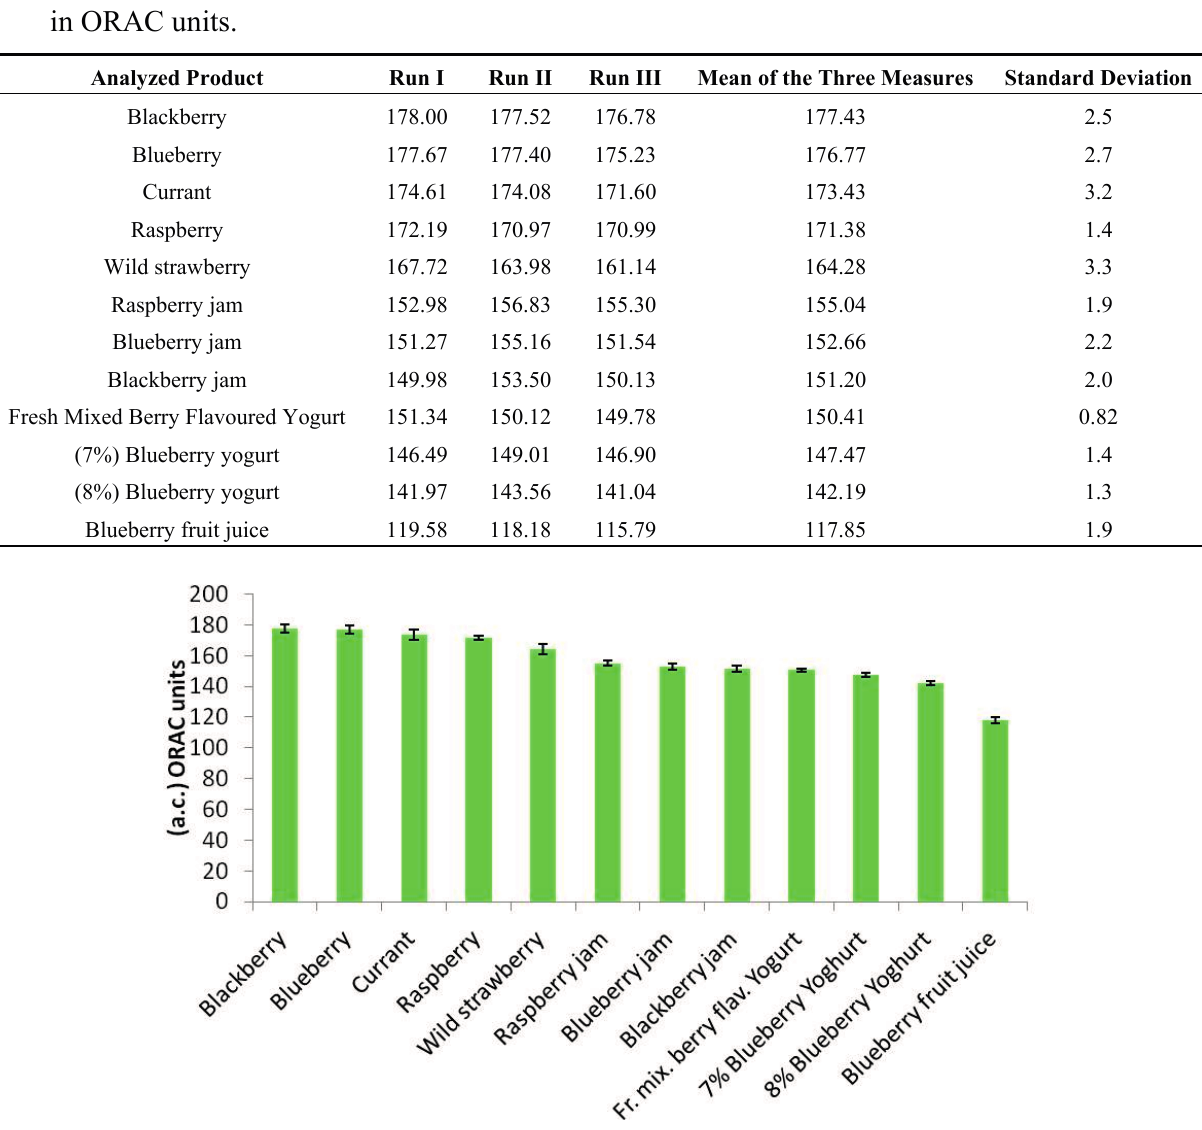
Figure 3. Histogram of antioxidant capacity values (a.c.), obtained using the spectrofluorimetric method. Results expressed in ORAC